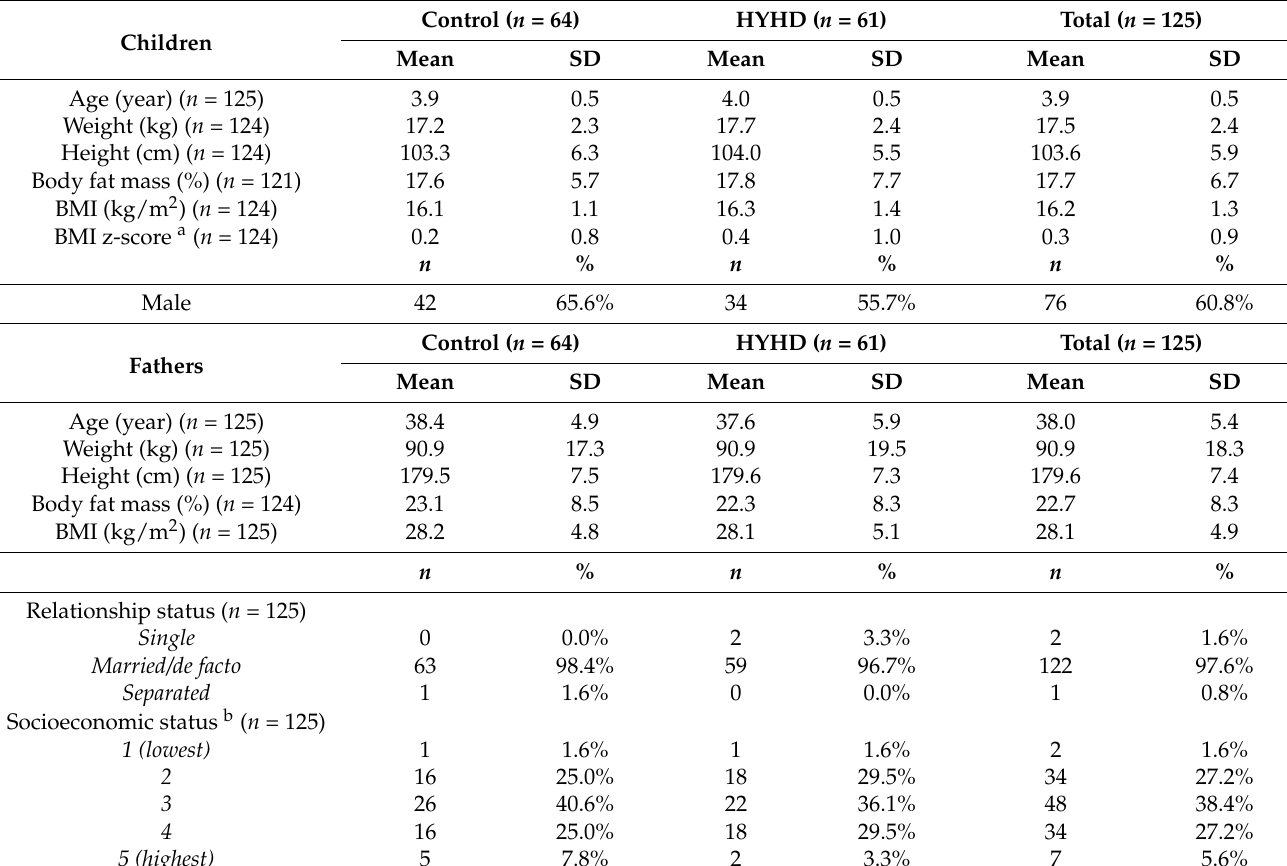
Table 1. Demographic characteristics of study